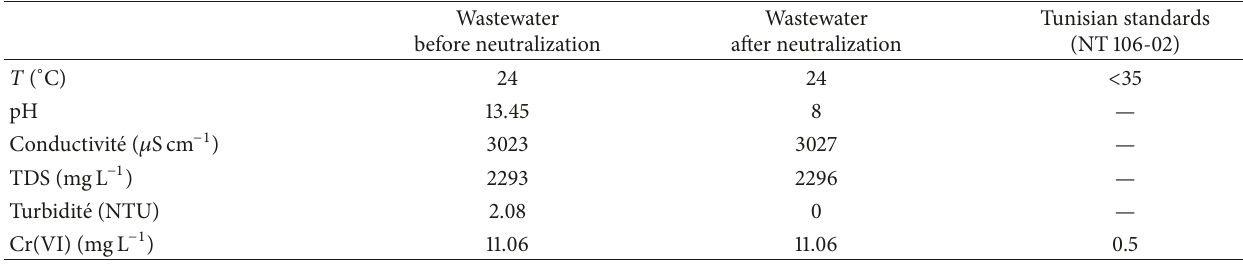
Table 4: Water quality of car shock absorber factory before and after neutralization and comparison with Tunisian standards liquid discharges into the network “National Office for Sanitation” (ONAS) (NT 106-02).